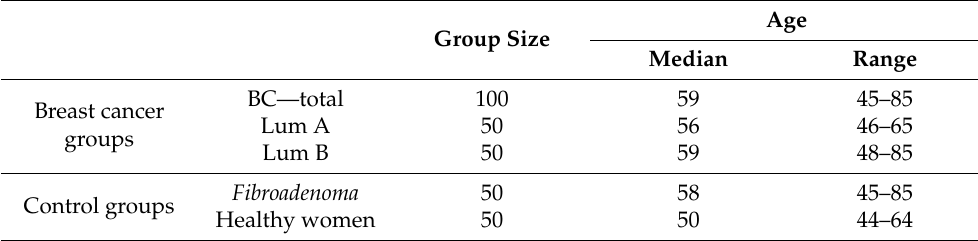
Table 1. Group size and age characteristic of examined preoperative groups: breast cancer total group (BC-total) with distinguished breast cancer Luminal A (Lum A) and Luminal B HER2-negative (Lum B) subgroups of patients and control groups: benign breast lesions ( fibroadenoma ) and healthy women. Age Group Size Median